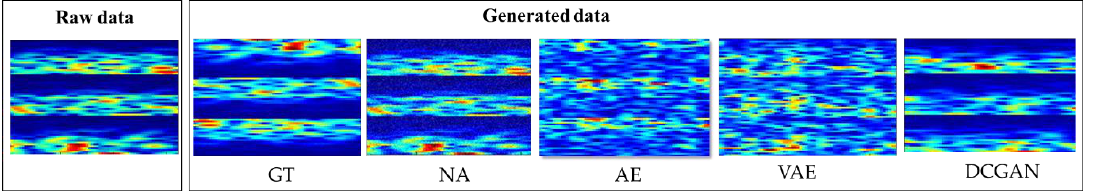
Table 6. Classification accuracy of the methods for the BCI competition IV dataset 1 (baseline: 74.5 ± 4.0%).